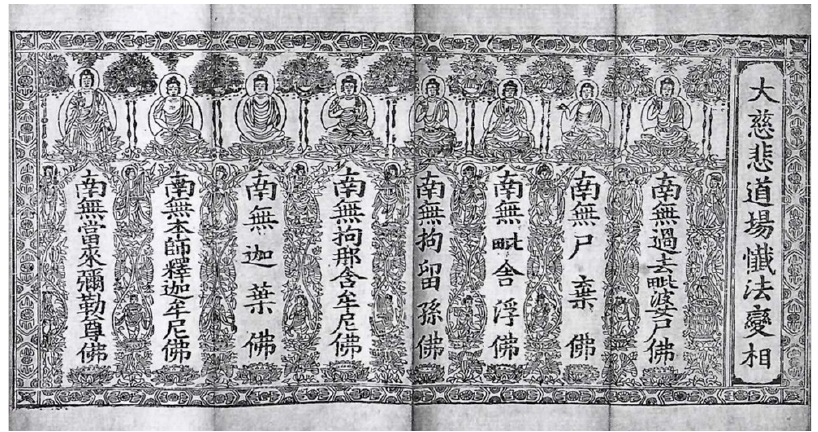
Figure 7. Sanggyojeong Edition of Repentance Rituals of Compassion Altar, late Goryeo-early Joseon dynasty, 34.0 × 14.0 cm, Leeum Museum of Art, Korea (Cheon 1992, p. 175).